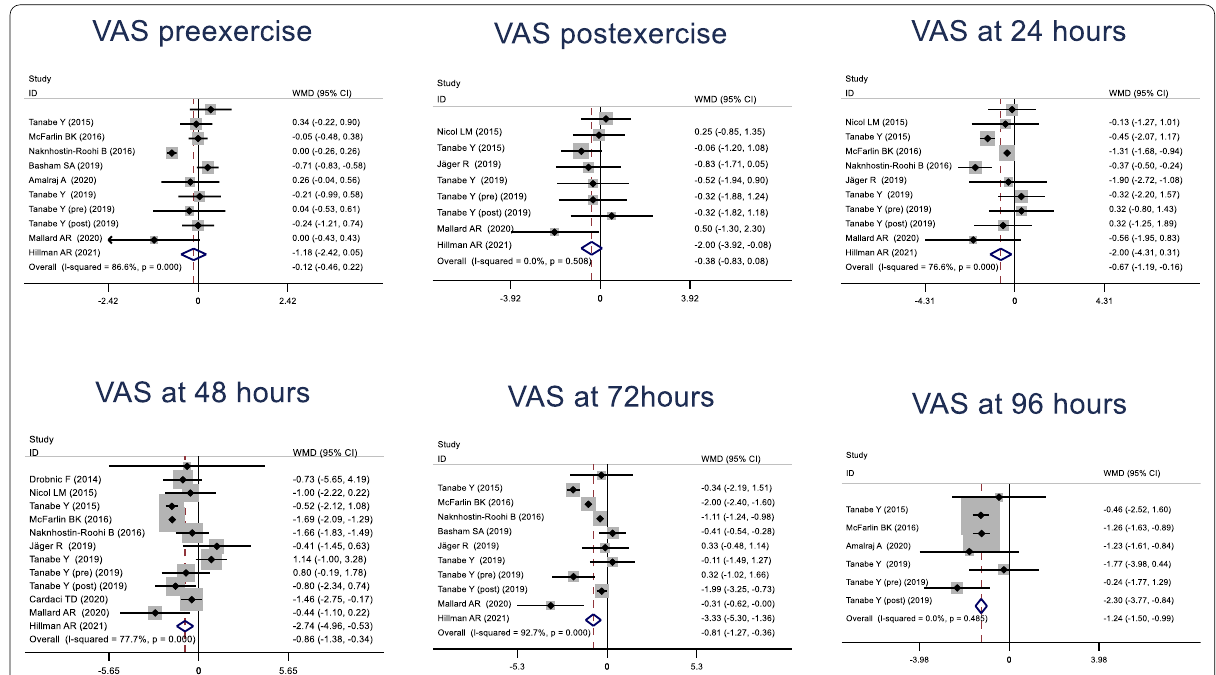
Fig. 2 Forest plot for comparison of VAS score at pre-, post-, 24, 48, 72 and 96 h after exercise between curcumin supplement versus